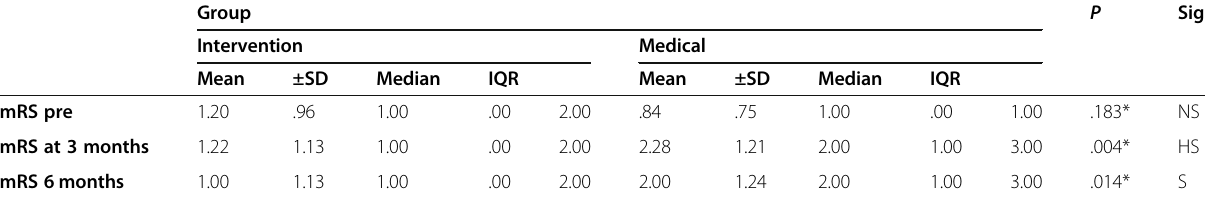
Table 5 mRS at baseline, 3 and 6 months of both groups Group